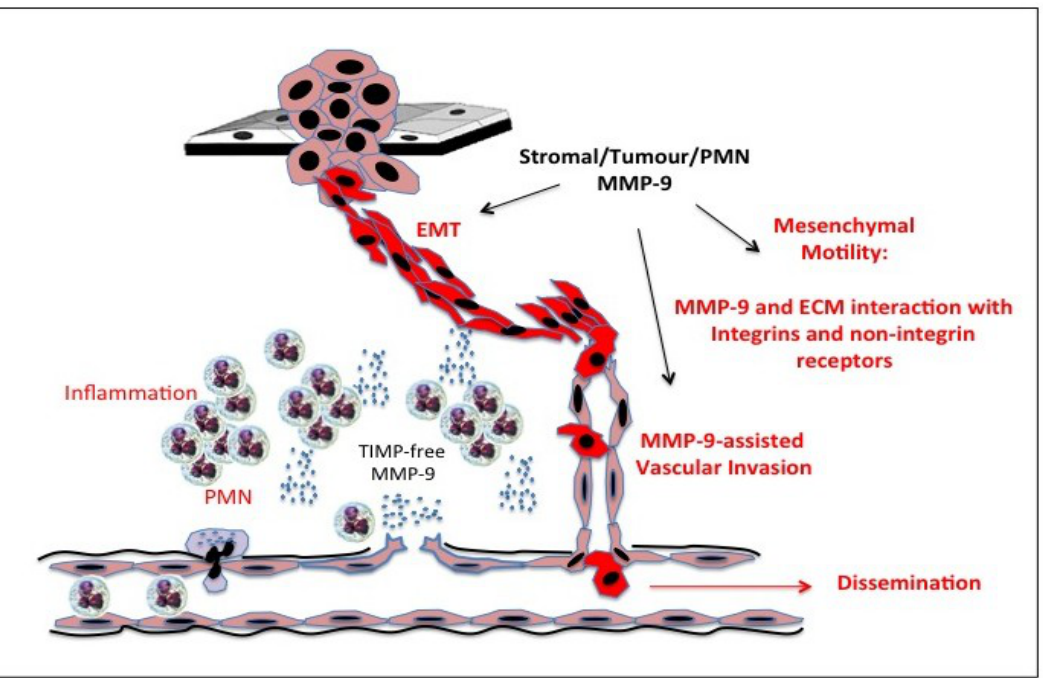
leukocyte (PMN)-derived tissue inhibitor of metalloproteinase (TIMP)-free gelatinase B/MMP-9, and gelatinase B/MMP-9 of stromal and tumour origin, in epithelial-mesenchymal transition (EMT) and subsequent integrin and non-integrin mediated mesenchymal motility and invasion and immature tumour blood